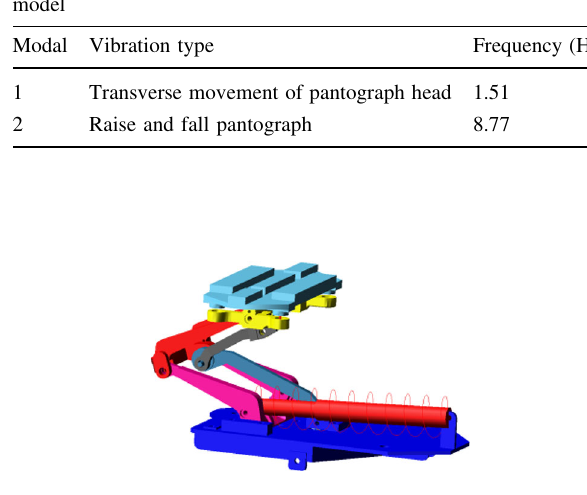
Fig. 4 Dynamic characteristics analysis of pantograph